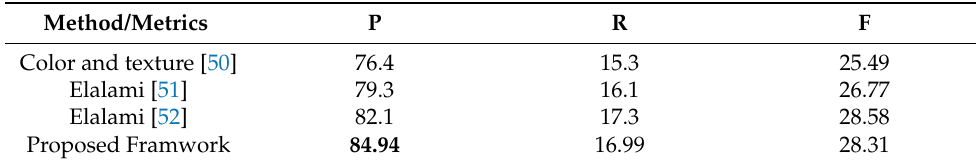
Table 10. Comparison between recent CBIR approaches and the HKFV+BFS on Oxford Flower-17